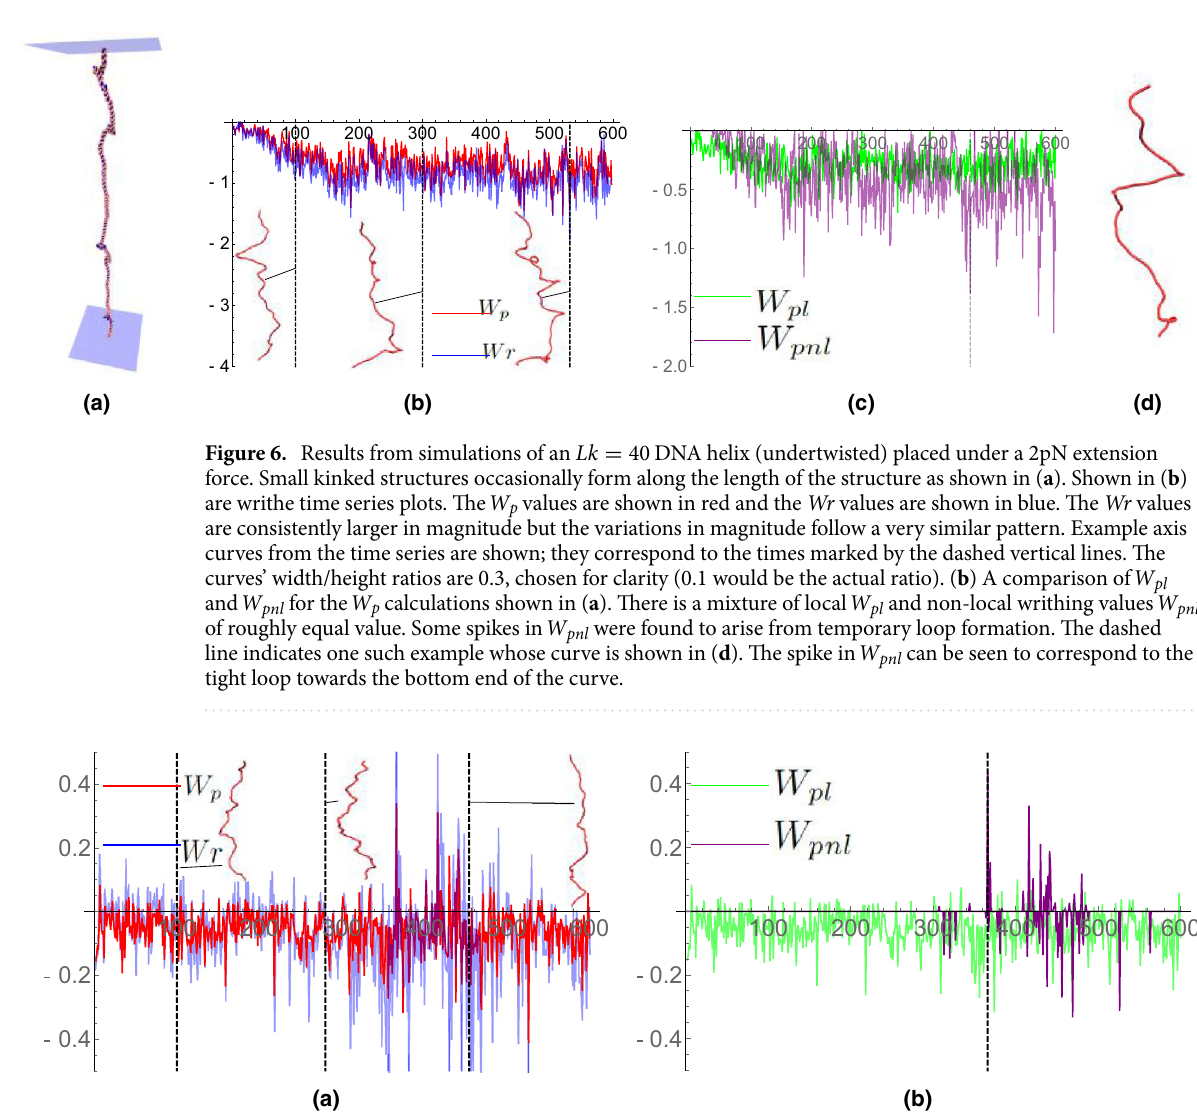
Figure 7. Writhe time series plots for an undertwisted DNA molecule ( Lk = 40 ) subjected to an 8pN pulling force. ( a ) A comparison of W p and Wr for the time series. The W p values are shown in red and the Wr values are show in blue. The Wr values are consistently larger in magnitude. Example axis curves from the time series are shown; they correspond to the times marked by the dashed vertical lines. The curves’ width/height ratios are 0.3, chosen for clarity (0.1 would be the actual ratio). ( b ) A comparison of W pl and W pnl for the W p calculations shown in ( a ). For the significant majority of curves, there is only local